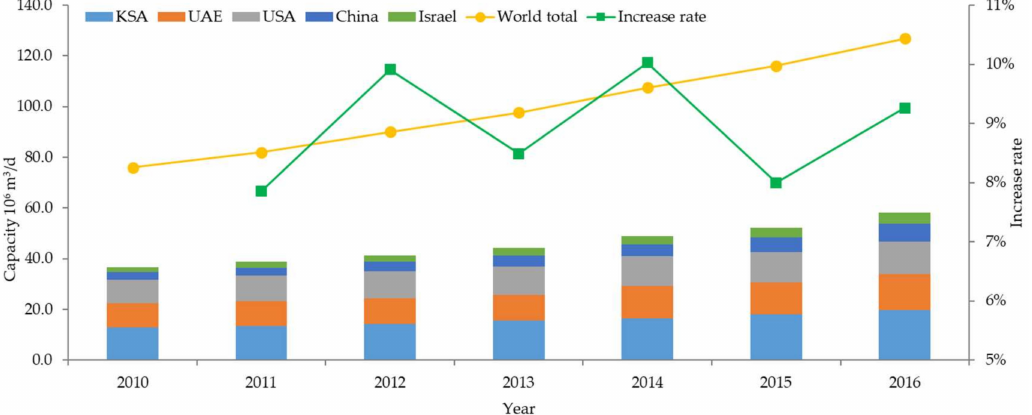
Figure 1. Water desalination capacities of the world and selected countries from 2010 to 2016 (derived from [2]). KSA: Kingdom of Saudi Arabia; UAE: United Arab Emirates.